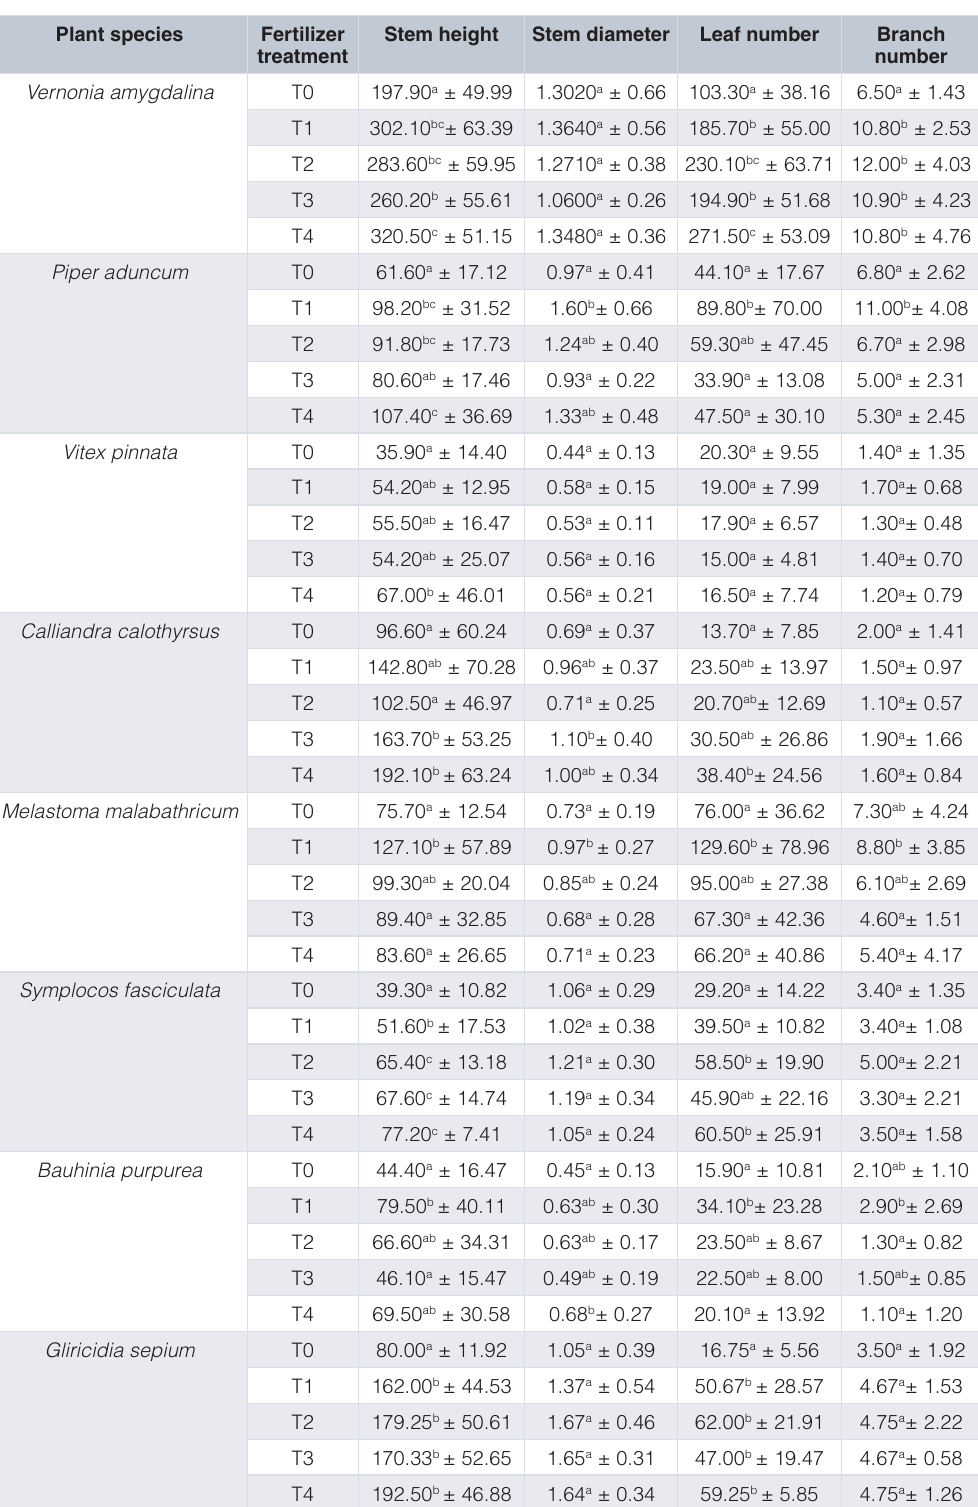
Table 1. Fertilization effect on the average number of plant height, stem diameter, and leaf and branch number. T0 = 0 g (control), T1 = 40 g, T2 = 80 g, T3 = 120 g and T4 = 160 g of NPK. Number followed by the same letter in the same column show no significant difference in the DMRT test ( p=0.05 ) after analysis by